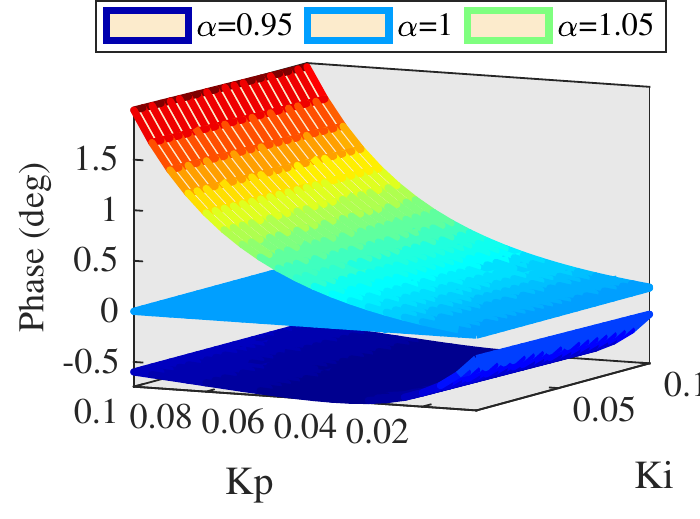
Figure 18. Phase of AMFC ( α = 0.95 to 1.05).